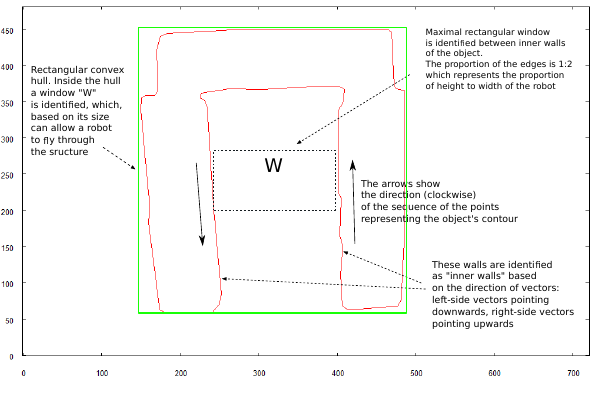
Figure 31. Calculating if robot can fly under structure.